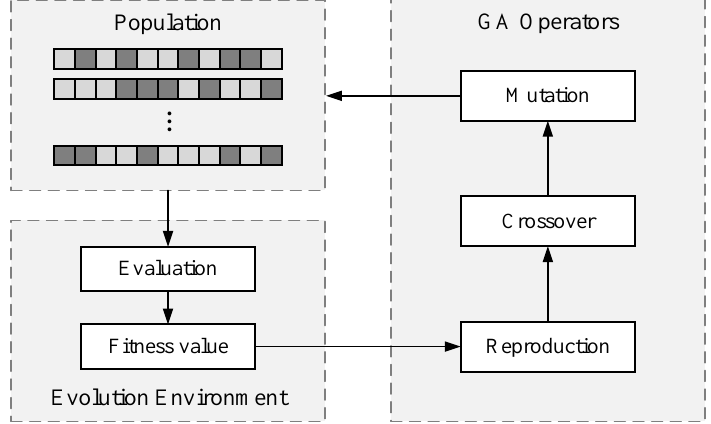
Figure 8. Flow diagram of the genetic